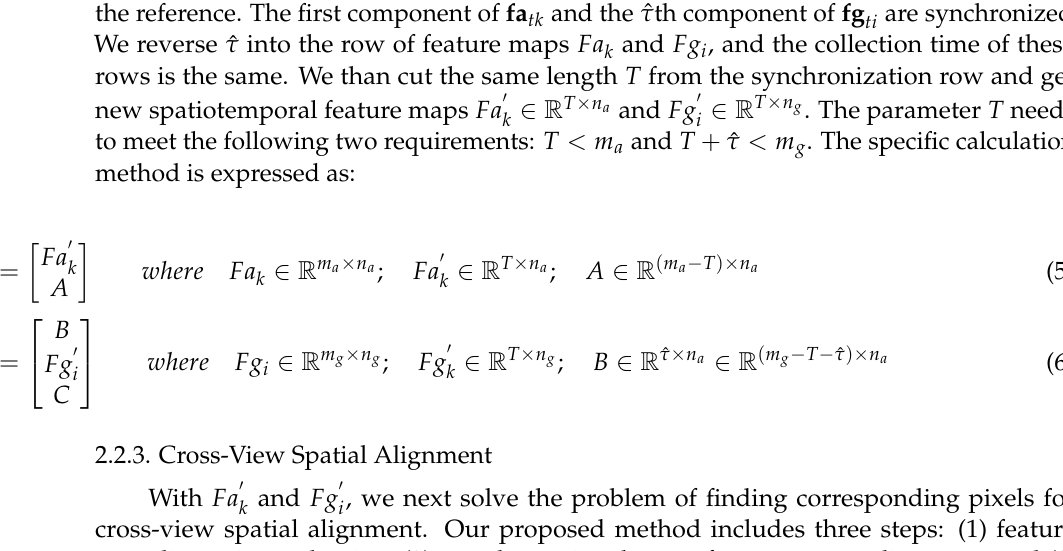
( left ) and Fg (cid:48) ( right ) is firstly i k